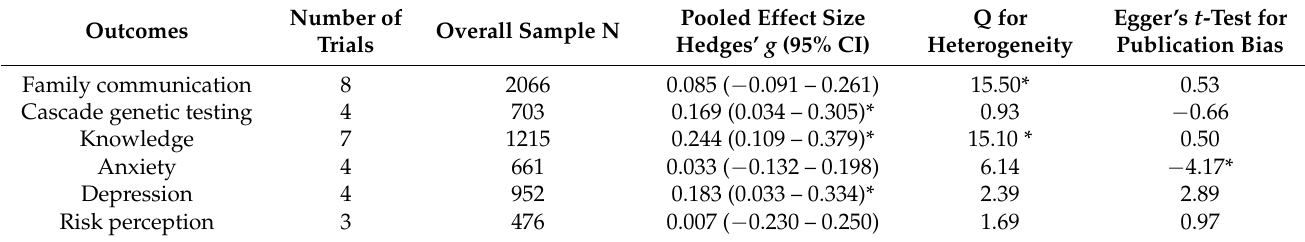
Table 3. Pooled effect sizes of outcomes.